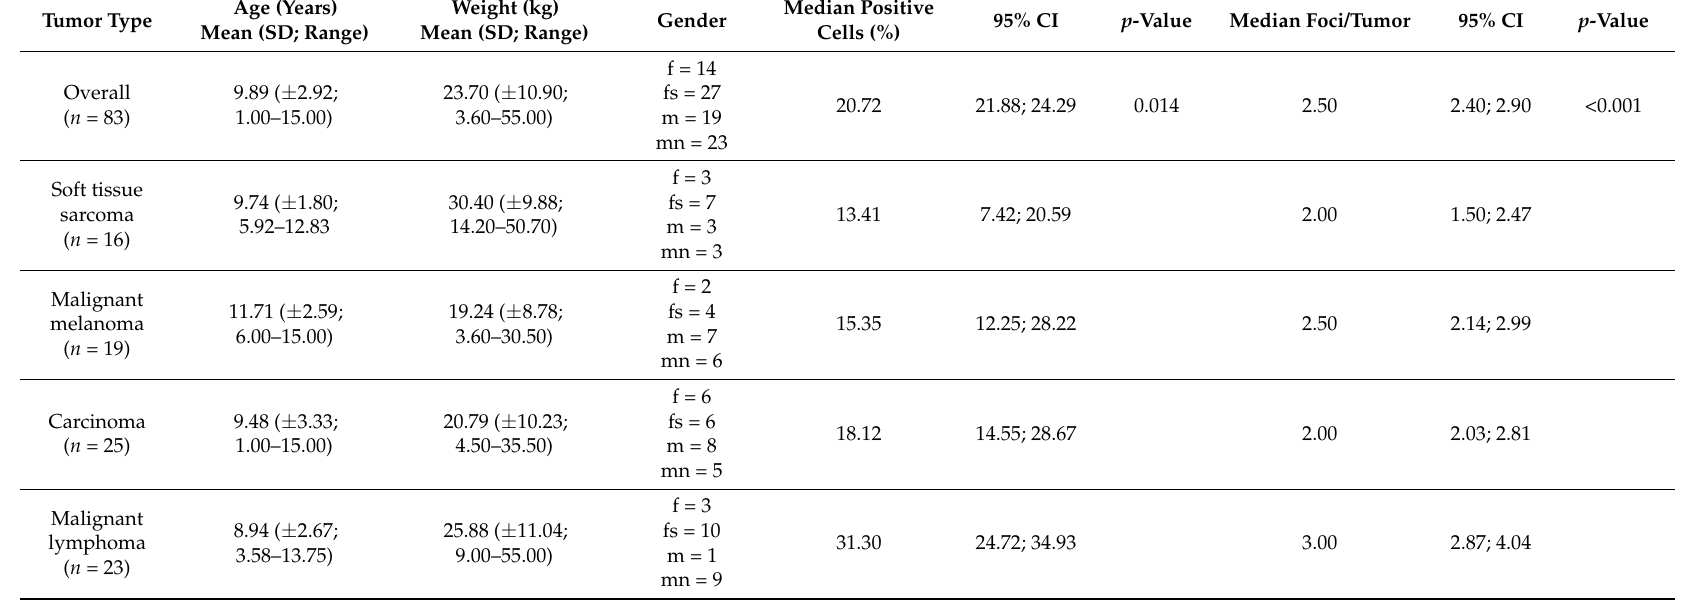
Table 3. Patient specific details for baseline values of γ H2AX foci. f = female, fs = female spayed, m = male, mn = male